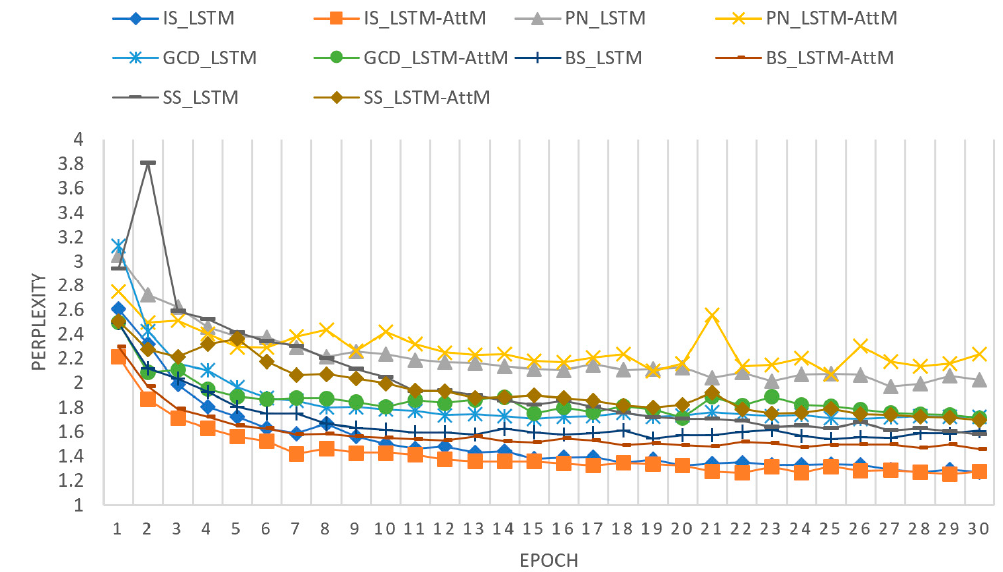
Figure 6. Epoch-wise perplexity for LSTM and LSTM-AttM models with 200 hidden layers for various problems.